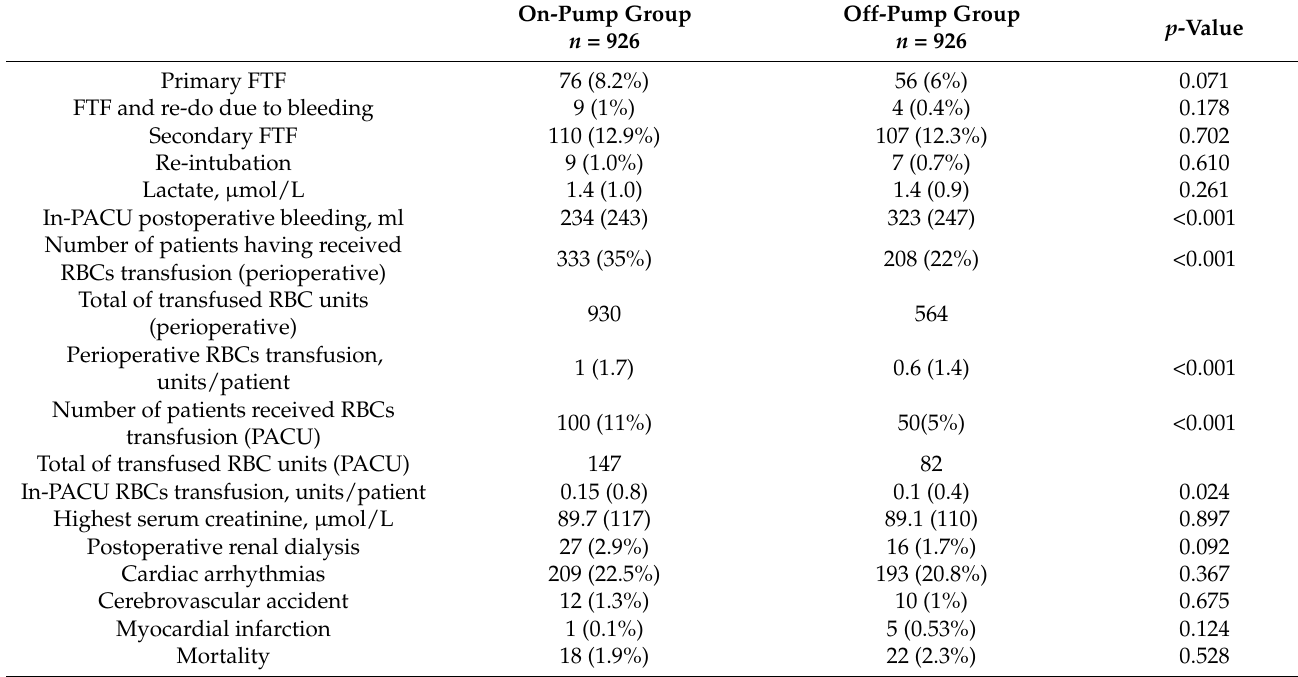
Table 3. Postoperative outcome and complications for patients included in the study. Values are the mean (SD) or number